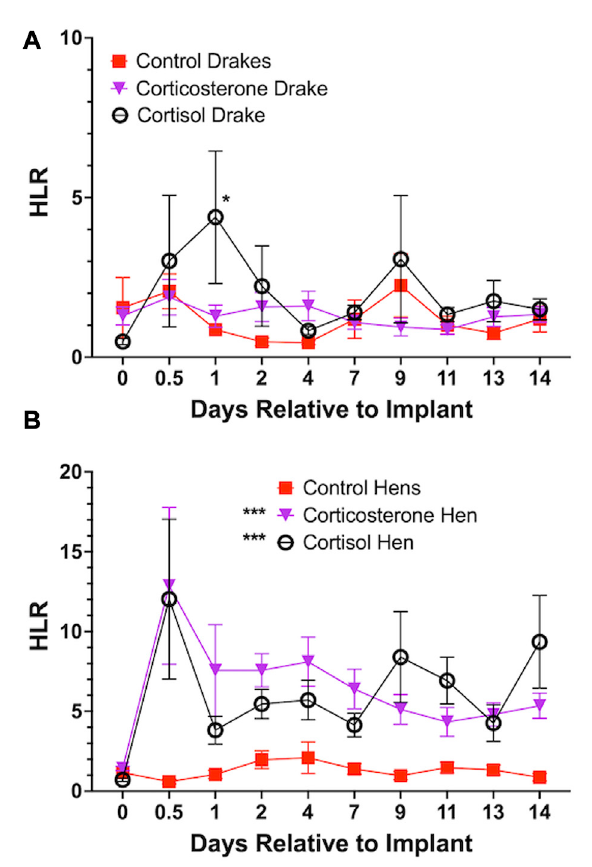
FIGURE 3 HeterophilandLymphocyteratioinDrakes (A) andHens (B) .Both cortisol and corticosterone showed a signi fi cant increase in hen HLR at all time points during the experiment compared to controls. In drakes,onlycortisolelicitedasigni fi cantincreaseinHLRandonly 1 day following onset of treatment compared to controls